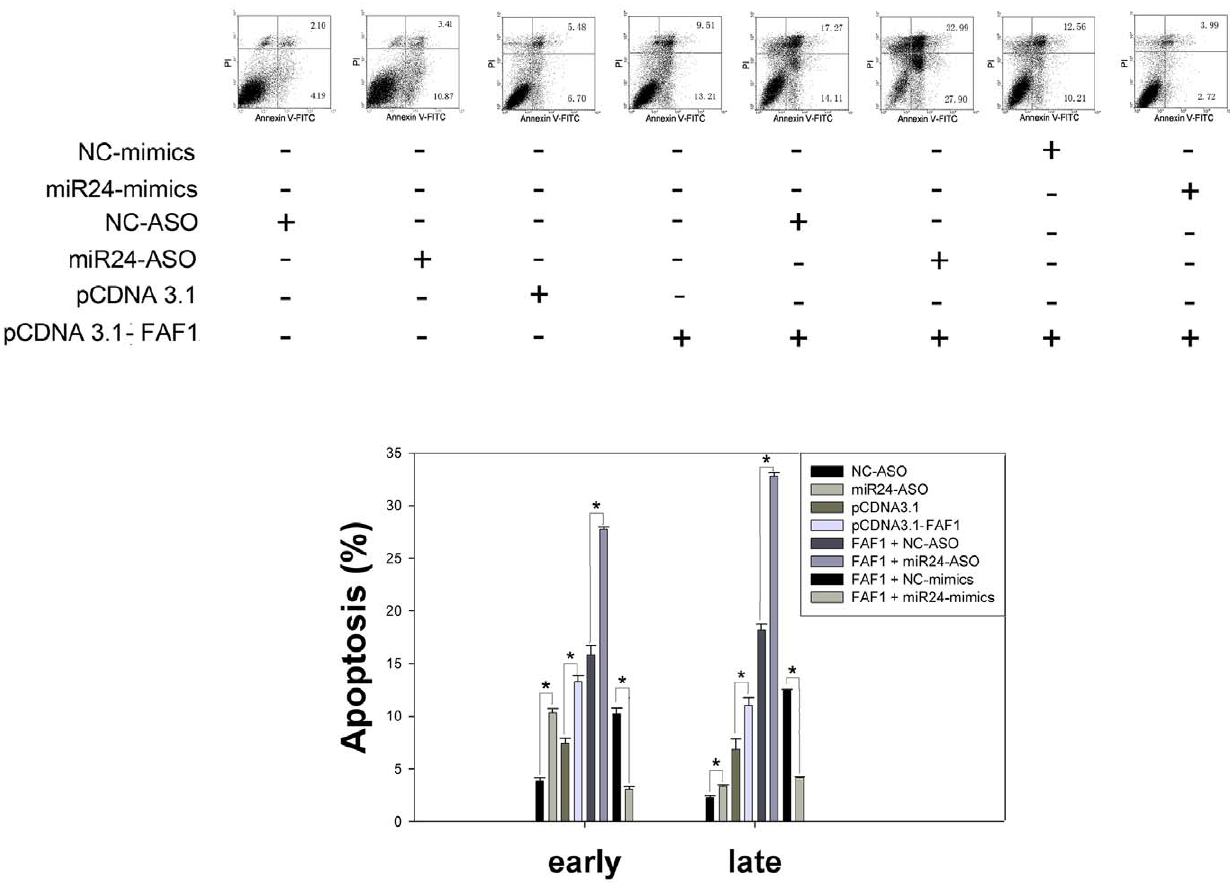
Figure 3. miR-24 regulates apoptosis by targeting FAF. DU-145 cells were treated with the indicated reagents and apoptosis was measured by FACS 48 h after transfection (n=3 6 SE, * p , 0.01). Not only did down-regulation of miR-24 induce apoptosis, but overexpression of FAF1 also induced apoptosis in DU-145 cells. The percentage of apoptotic cells became much higher when pcDNA3.1-FAF1 and miR-24-ASO were co-transfected. Apoptosis induced by the over-expression of FAF1 could be rescued by the miR-24-mimic. These data show that over-expression of miR-24 can protect DU-145 cells from FAF1-induced apoptosis, and that down-regulation of miR-24 can increase the apoptosis induced by FAF1 in DU-145 cells. Vectors were transfected at the concentration of 100 ng per well; mimics and ASO were transfected at the concentration of 20 nM per well in a 12- well plate.